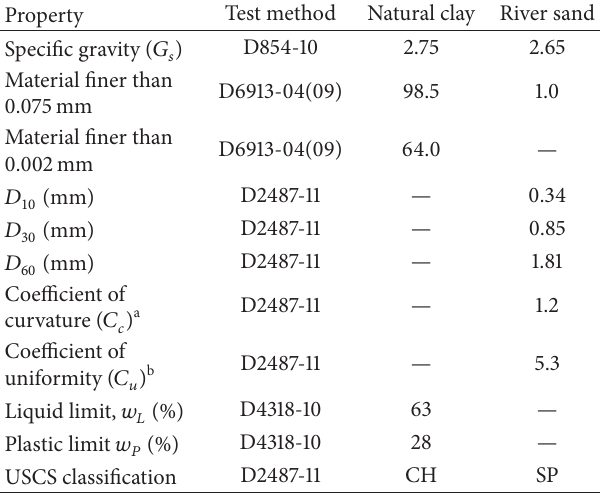
Table 1: Geotechnical index properties of the investigated materials.